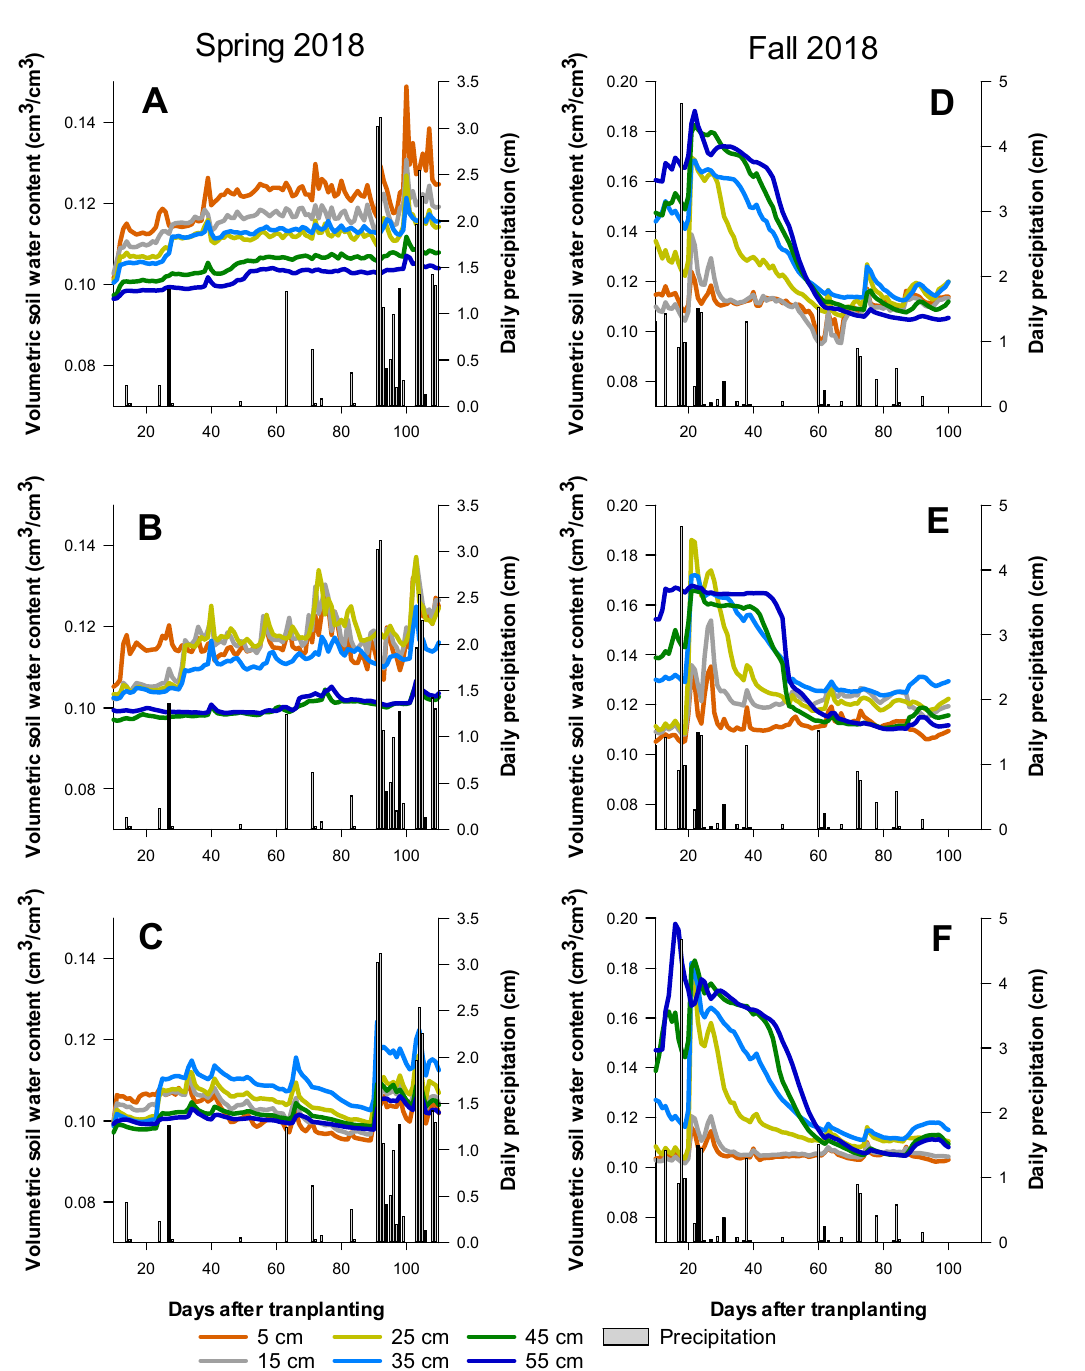
Figure 3. Average daily soil moisture distribution and daily precipitation for full irrigation ( A ), regulated deficit irrigation ( B ), deficit irrigation ( C ) during spring 2018 season and full irrigation ( D ), regulated deficit irrigation ( E ), and deficit irrigation ( F ) during fall 2018 season.